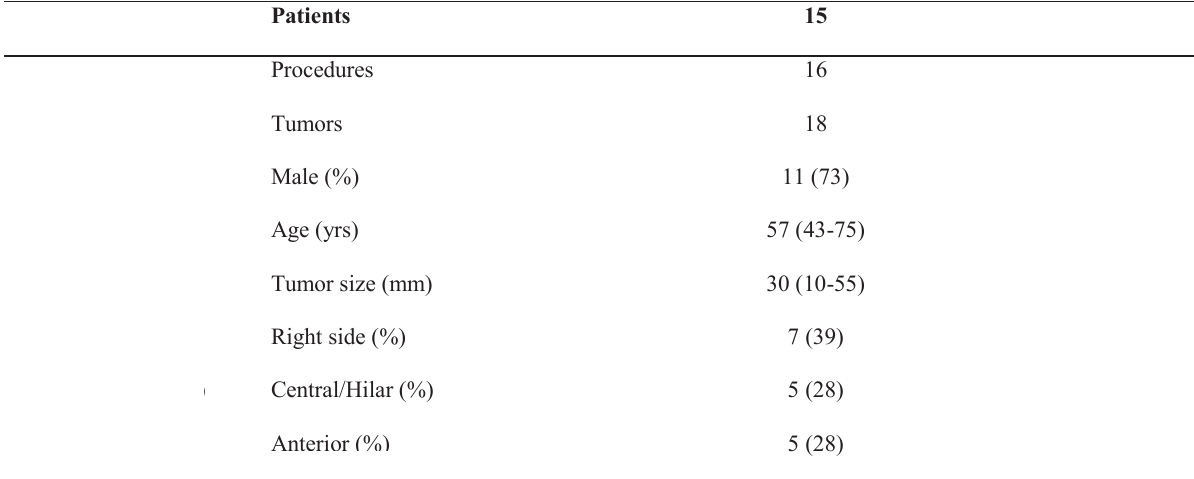
Table 1 – Demographic Data. Table 1 - Demographic Data.